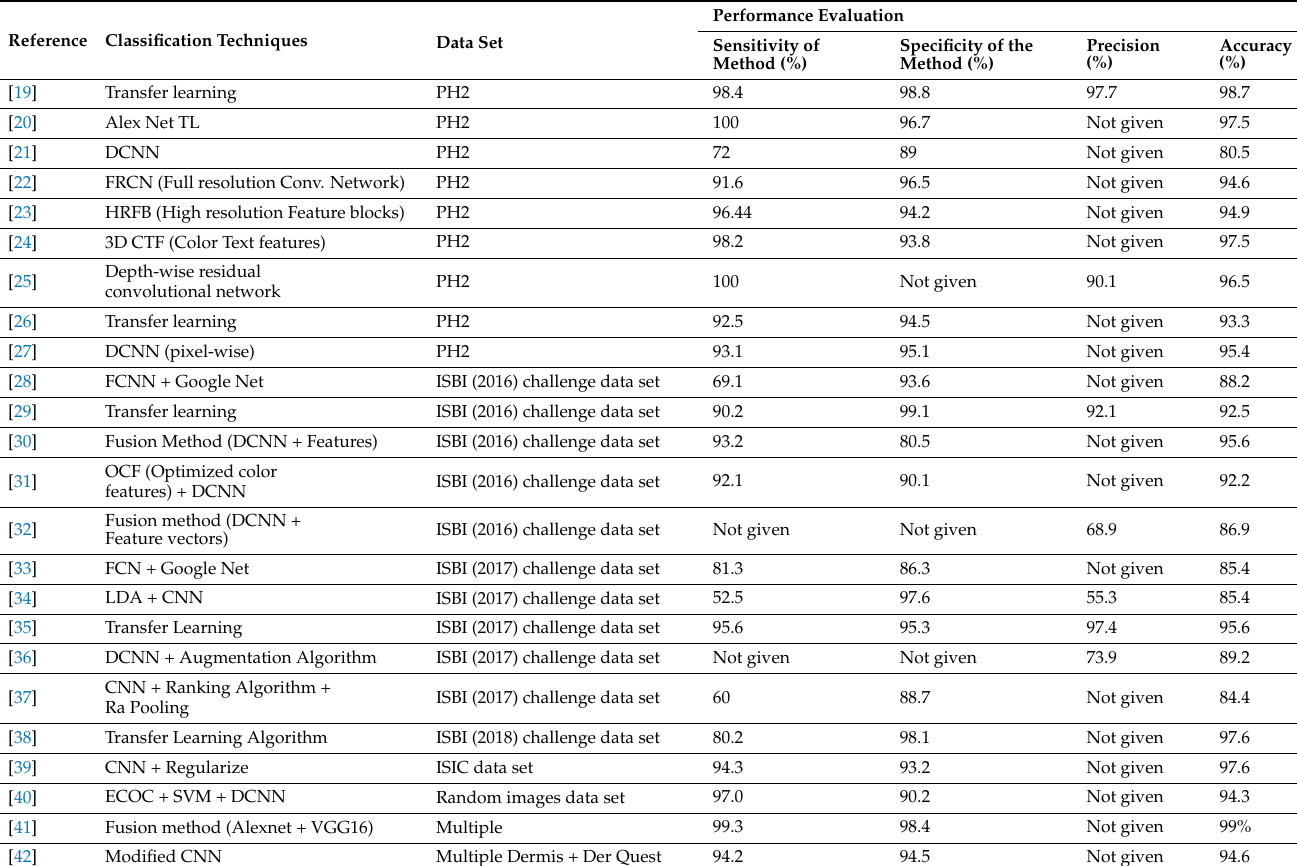
Table 7. Comparison of different DL